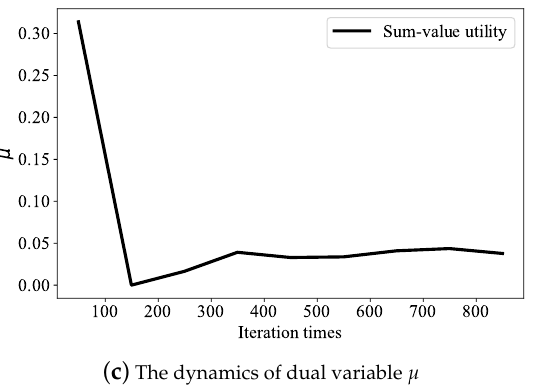
Figure 8. Convergence of the gradient-based solution for aged utility maximization in spatial- temporal crowdsensing.